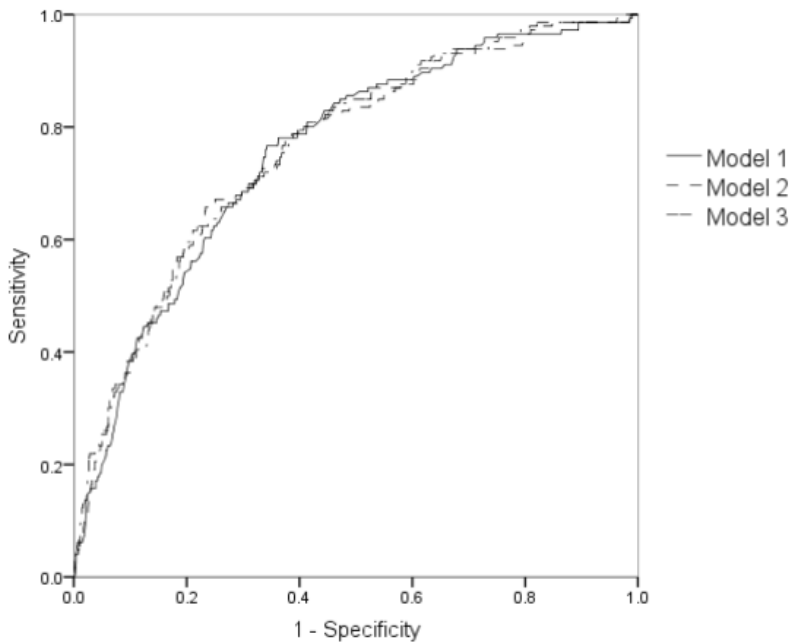
Figure 1. ROC curve of different statistical models. Models were built by logistic regression, varia- bles contained in each model were as follows: Model 1: Age, sex, hyperlipidaemia, hypertension, smoking, and alcohol drinking behavior. Model 2: Variables in model 1 and rs184003 and rs4845625. Model 3: Variables in model 1 and PRS.